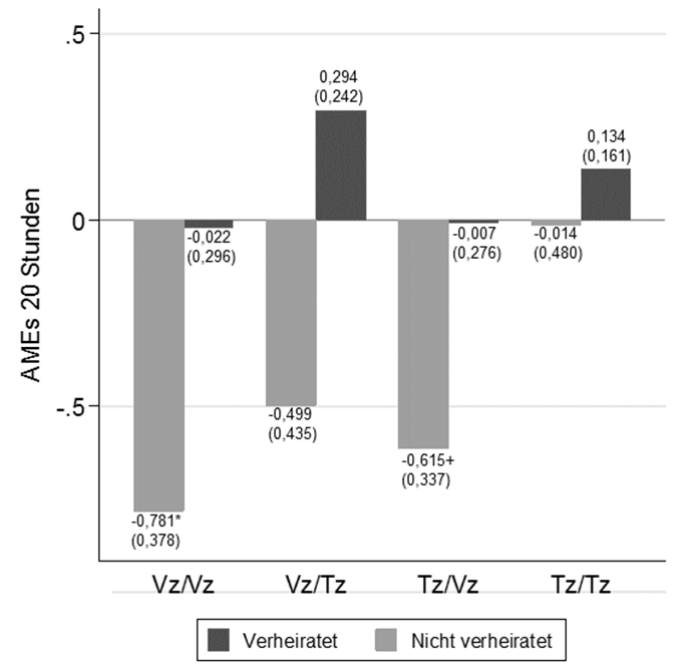
AMEs für eine Teilzeitstelle (Stundenumfang: 20 Stunden, Referenz: 40 Stunden, Standardfehler in Klammern) nach aktueller Erwerbskonstellation und